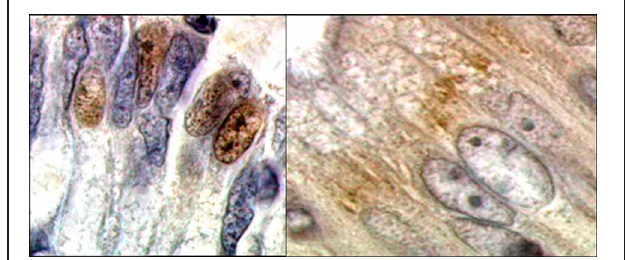
FIGURE 1 | Diffuse localization of wild-type MUTYH protein in colonic epithelial cells, as evidenced with specific antibodies (Courtesy of Dr. M.